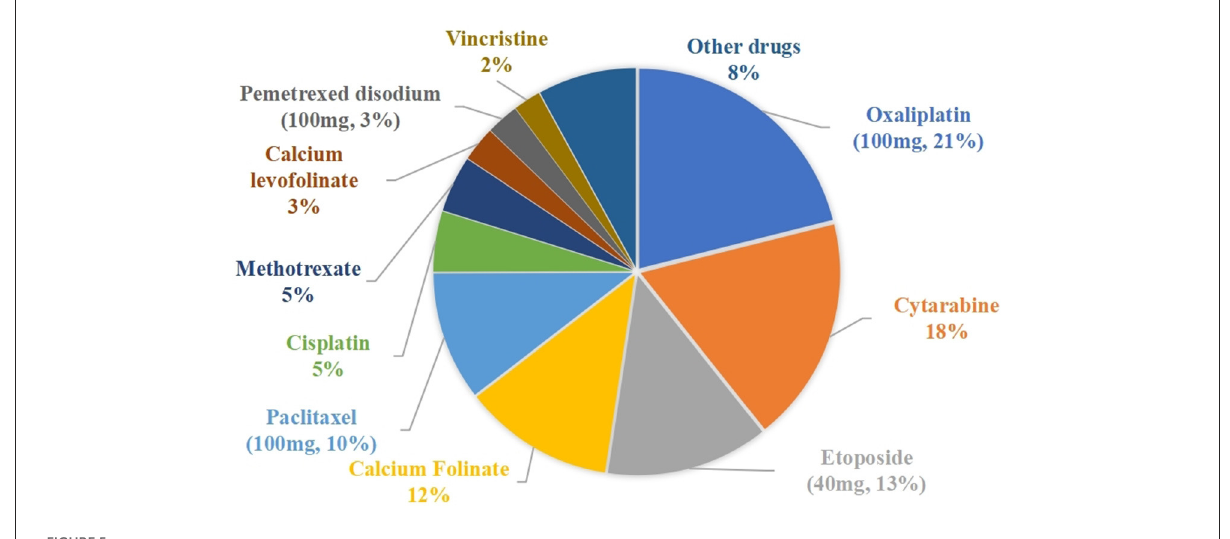
FIGURE5 Percentage of drug costs